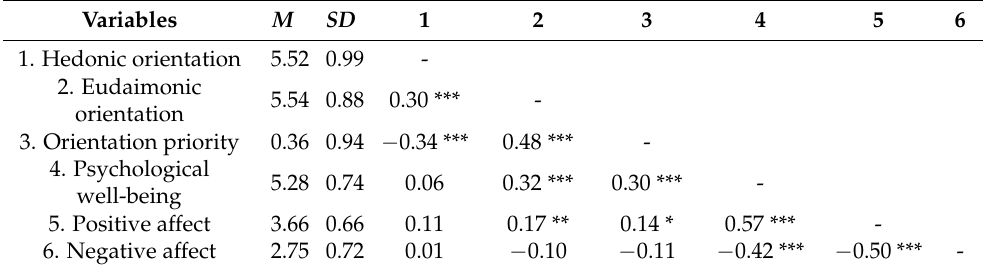
Table 1. Means, standard deviations, and zero-order correlations of the study variables.